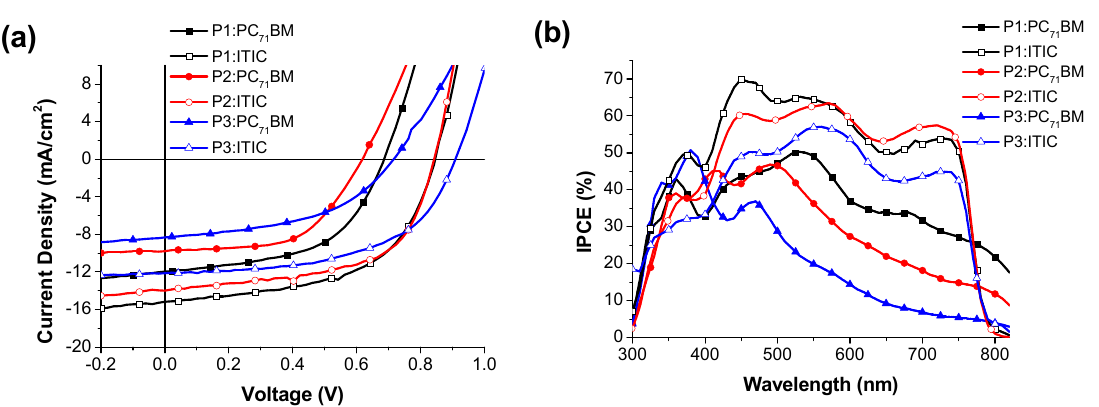
Figure 5. ( a ) J - V characteristics and ( b ) incident photon-to-electron conversion efficiency (IPCE) spectra of the copolymer:PC 71 BM or ITIC-based polymer solar cells (PSCs) under illumination of AM 1.5 G, 100 mW/cm 2 . Table 3. Photovoltaic performances of the bulk heterojunction solar cells.